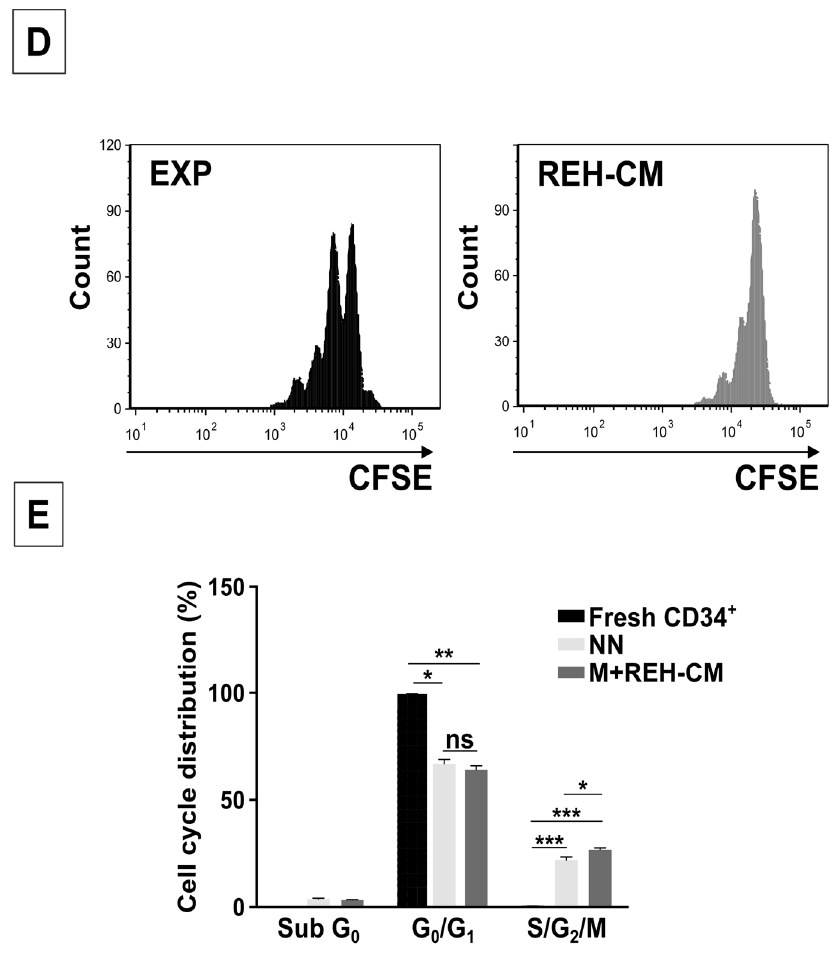
Figure 1. Increased proliferation capacity of CD34+ cells in the LN. ( A ) CD34+ cell proliferation in the NN and the LN was determined by cell staining with CFSE after three days of incubation. The histogram in the upper panel shows CD34+ cells synchronized by serum starvation (FBS removal for two days); ( B ) percentage of CD34+ cells at the corresponding number of cell divisions (0, 1, 2, 3, or 4) in the synchronized cells (black), NN (grey), and the LN (white) after three days of co-culture; ( C ) Percentage of CD34+ cells at the corresponding number of cell divisions (0, 1, 2, 3, or 4) in the synchronized cells (black), NN (grey) and the LN (white) after six days of co-culture; ( D ) CD34+ proliferation evaluated by CFSE staining after three days of culture in cell expansion conditions (FLT-3L, TPO, and SCF, all at 50 ng/mL) (EXP) or incubated with the REH-CM ( E ). Freshly isolated CD34+ or CD34+ from the NN and the M+REH-CM were stained with Hoechst 33342 dye for cell cycle evaluation by flow cytometry (FACSAria™ II, BD Biosciences, San Jose, CA, USA). (ns: non-significant, * p < 0.05, ** p < 0.01, *** p < 0.001). Results shown represent two independent experiments done in duplicates ( n = 4).